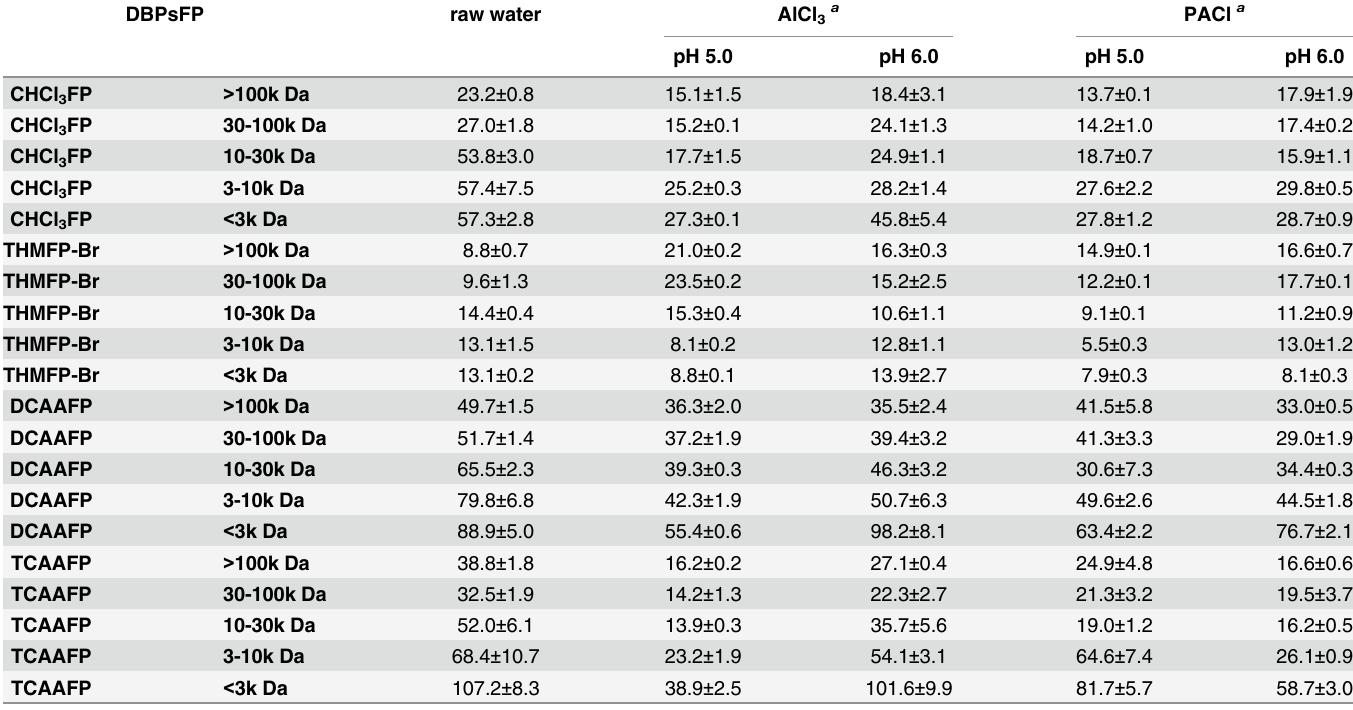
Table 1. Individual DBPsFP specific yields ( μ g/mg C) in different MW fractions of raw and coagulated HS